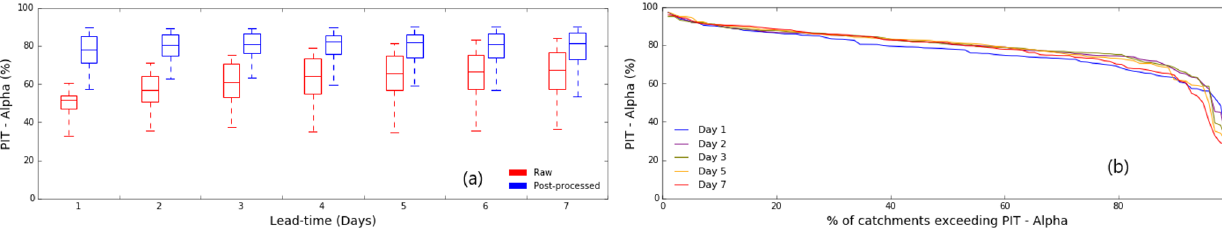
Figure 8. (a) Reliability (PIT) before and after streamflow applying ERRIS for the 100 forecast locations, and (b) percentage of forecast locations exceeding PIT (%) for ERRIS-corrected streamflow forecasts for different lead